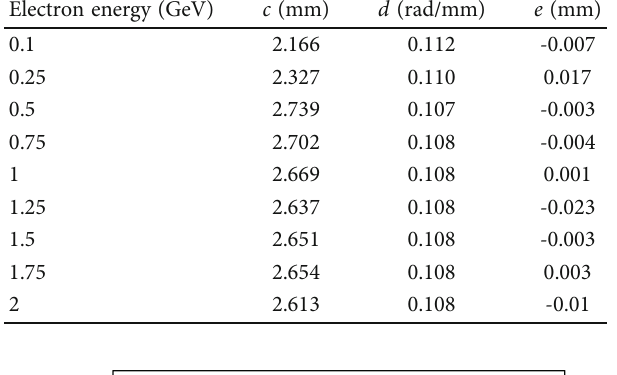
Figure 4: Dependence of the corrected position ð x LYSO crystals on the true coordinate ð x